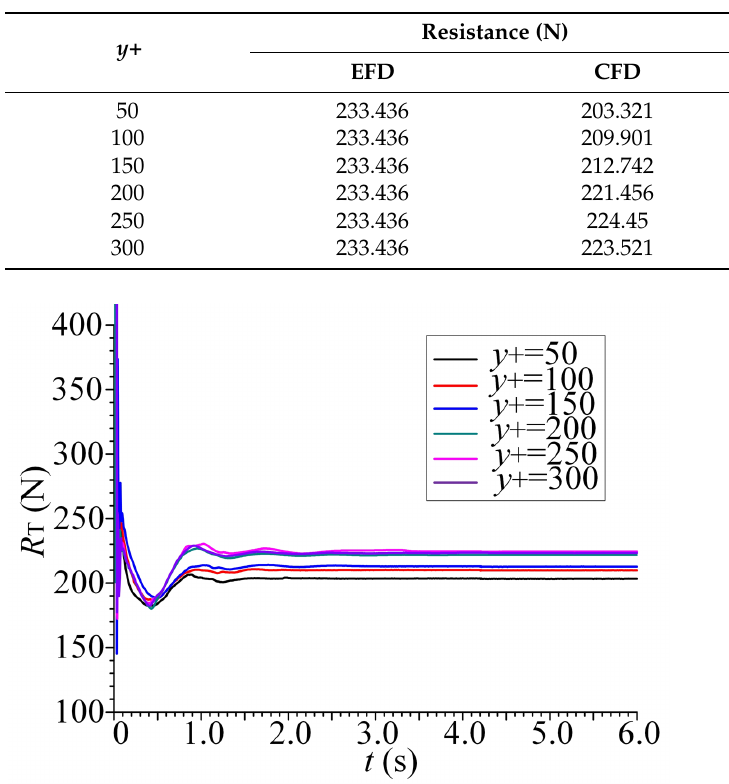
Figure 13. Resistance curves of the different y +.